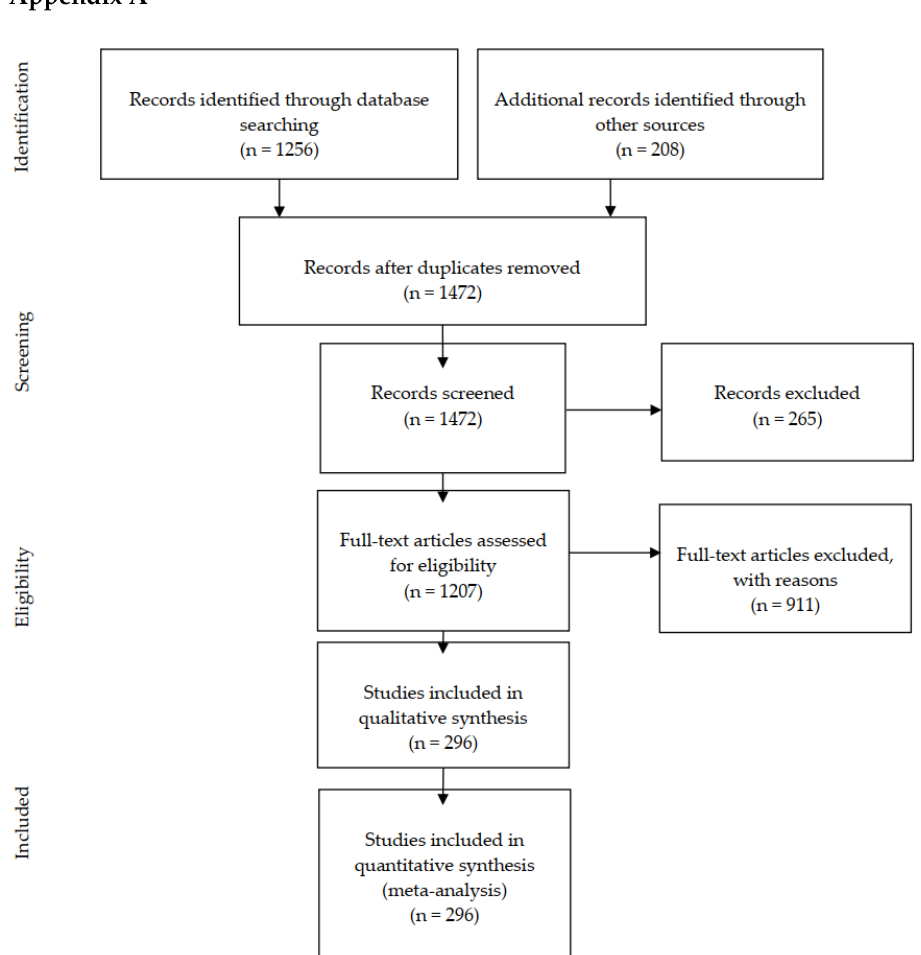
Figure A1. PRISMA flow chart summarizing the literature retrieval process.